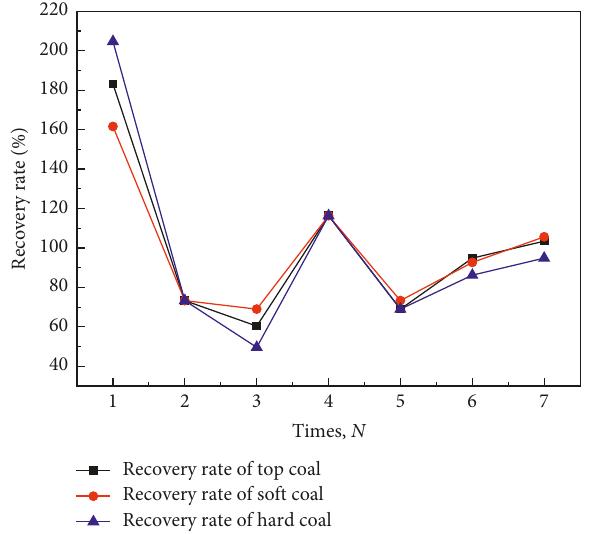
Figure 17: Recovery rates of two knife one